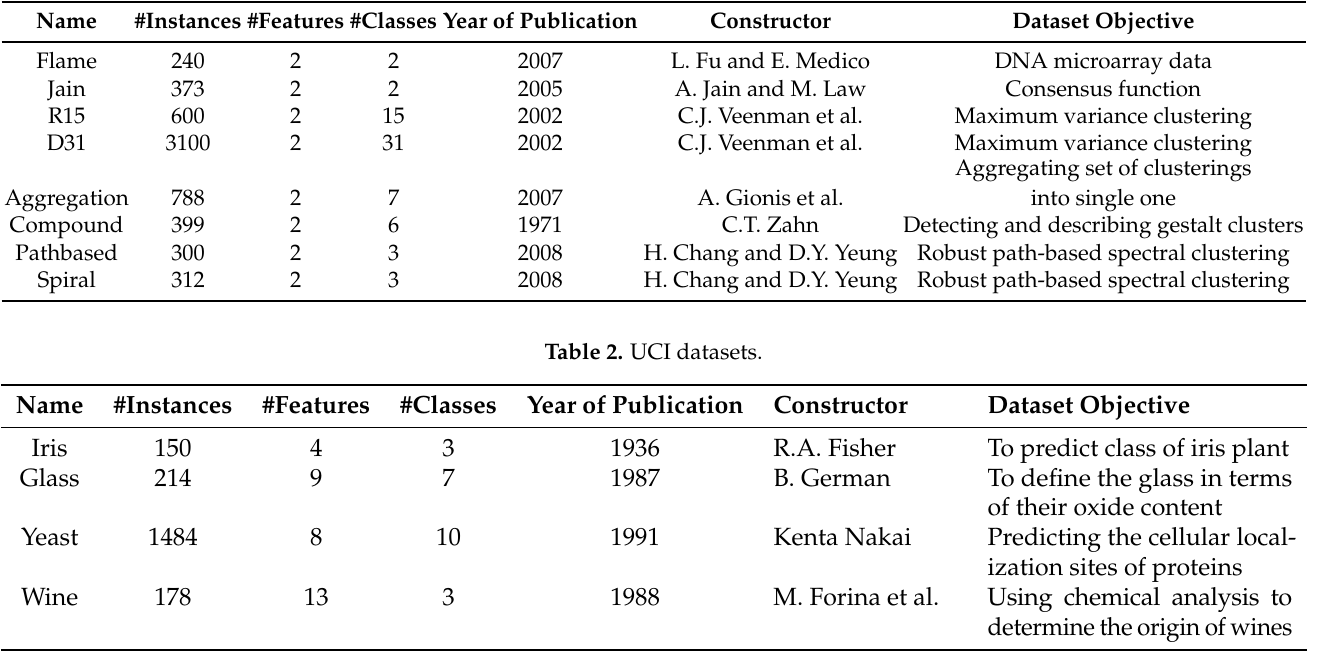
Table 1. Shape datasets.